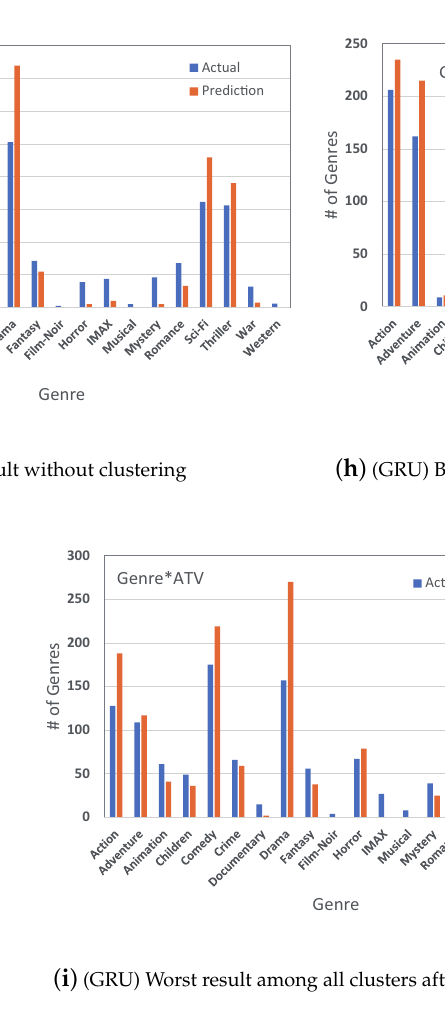
Figure 11. Result of clustering for RNN ( a – c ), LSTM ( d – f ), and GRU ( g – i ),